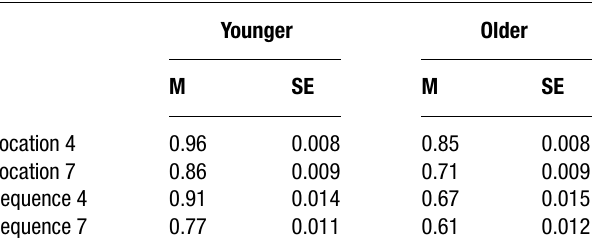
Table 3. SWM task: mean accuracy (M) and standard errors ( ± 1 SE) as a function of load (set size 4 versus set size 7) and test (location memory versus sequence memory) in younger and older